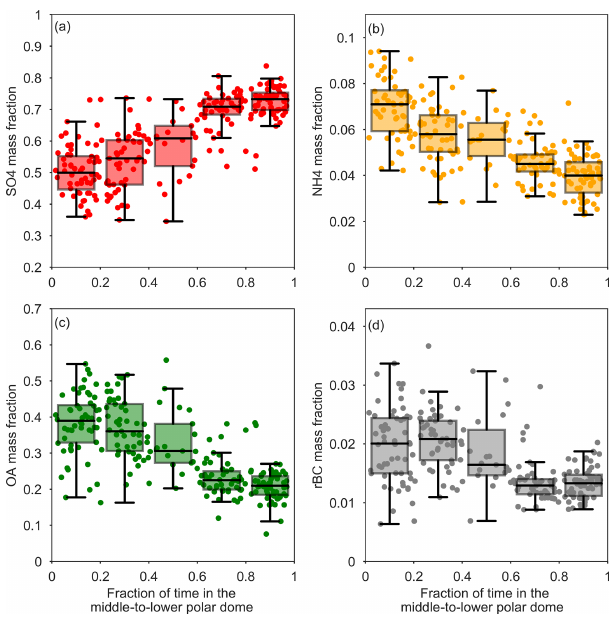
Figure 7. Sub-micron aerosol mass fractions versus FLEXPART- ECMWF-predicted fraction of the previous 10 days prior to measurement spent in the middle-to-lower polar dome (north of 69 ◦ 30 (cid:48) N, Bozem et al., 2018, and, based on trace gas profiles, below 265K, ∼ 1600m). Data points corresponding to individual FLEXPART-ECMWF releases are shown as circles, and summary statistics are shown as boxes (25th, 50th, 75th percentiles) and whiskers (5th, 95th percentiles) for data binned by time spent in the middle and lower polar